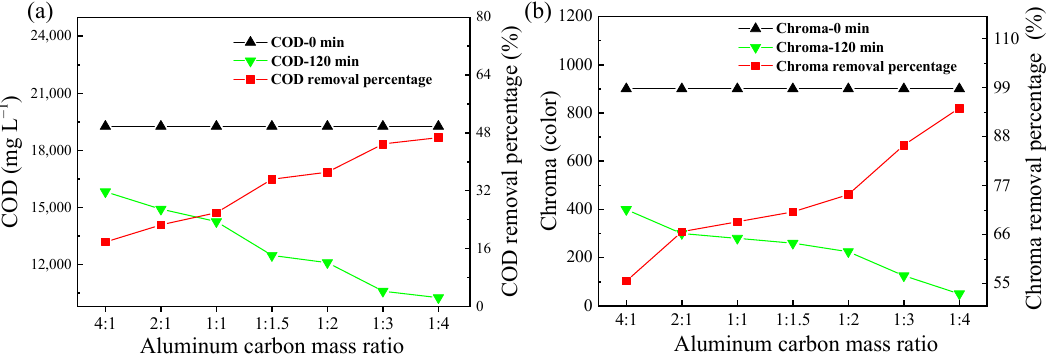
Figure 3. Influence of Al/AC mass ratio on ( a ) COD and ( b ) chroma removal at 2 h. Reaction conditions: Al scrap dosage, 80 g L − 1 ; rotation speed, 150 r min − 1 ; pH value, 10.